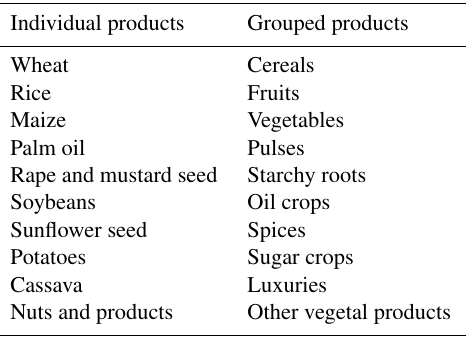
Table B1. Vegetal products and grouped vegetal products. Grouped products do not contain any products represented as staple products. The luxury group consists of tea, coffee, and cocoa.